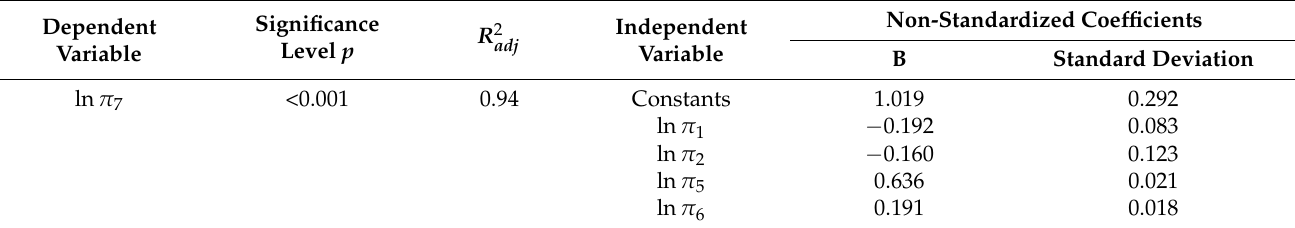
Table 5. Statistical analysis of the model.